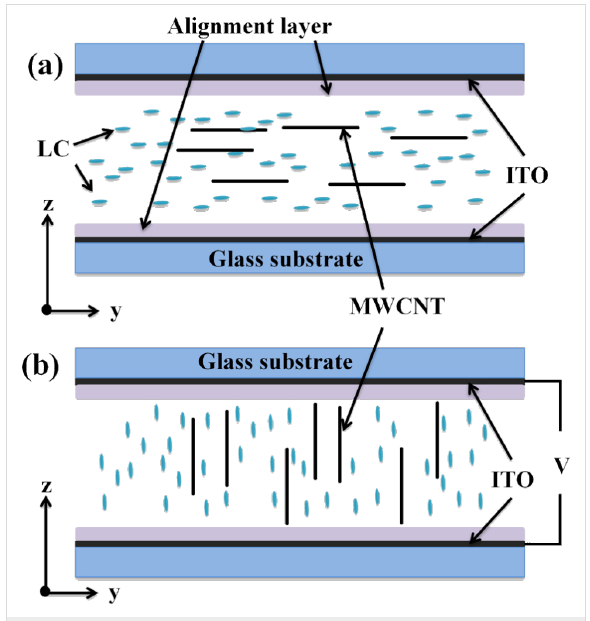
Figure 1: Schematic structure of a positive nematic MWCNTs-doped LC cell (a) without excitation voltage – planar orientation – and (b) at saturation voltage – vertical